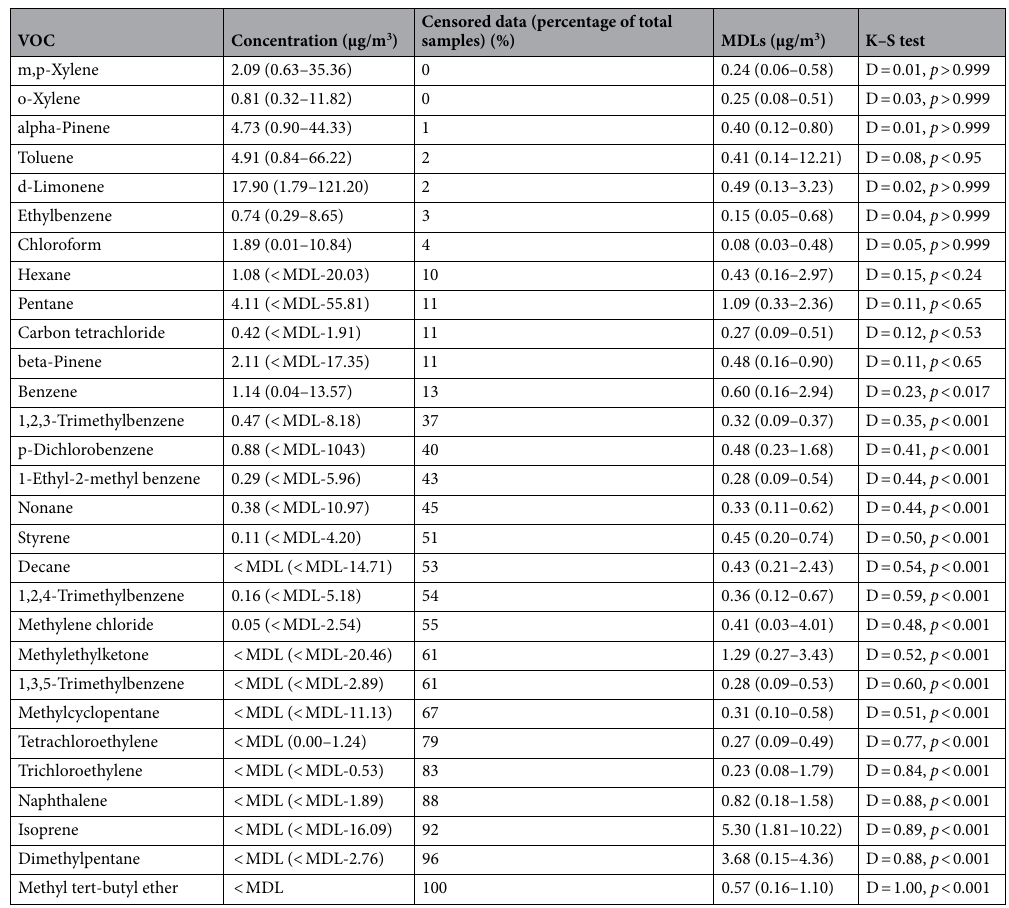
Table 3. Descriptive statistics for indoor air VOC data and results of K–S distributional testing. Concentrations are presented as median levels (5th percentile–95th percentile). Censored data are presented as percentages of samples out of the total number of samples below the method detection limit (MDL). MDLs (µg/m 3 ) are presented as median levels (minimum and